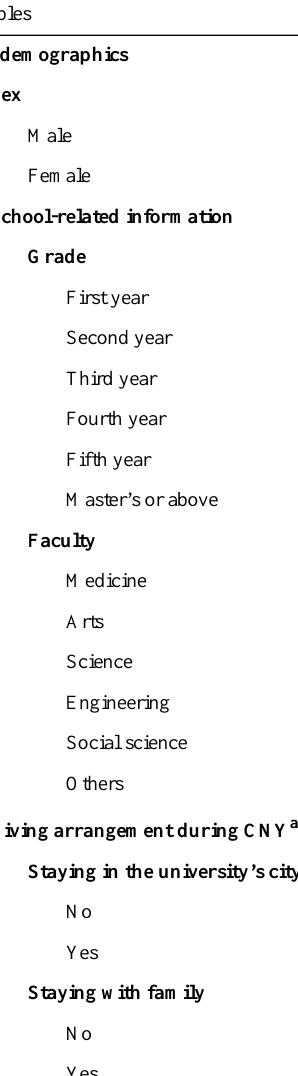
Table 1. Background variables of the participants